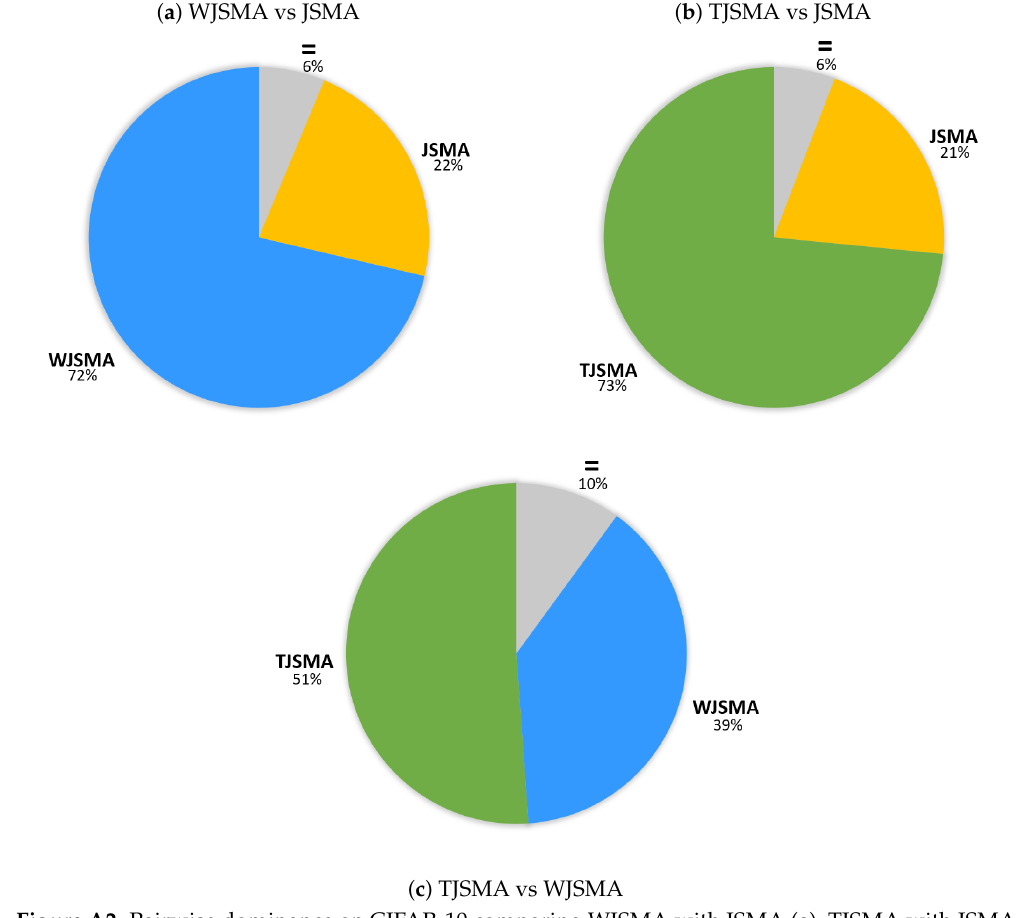
Figure A2. Pairwise dominance on CIFAR-10 comparing WJSMA with JSMA ( a ), TJSMA with JSMA ( b ) and TJSMA with WJSMA ( c ). “=” has the same significance as